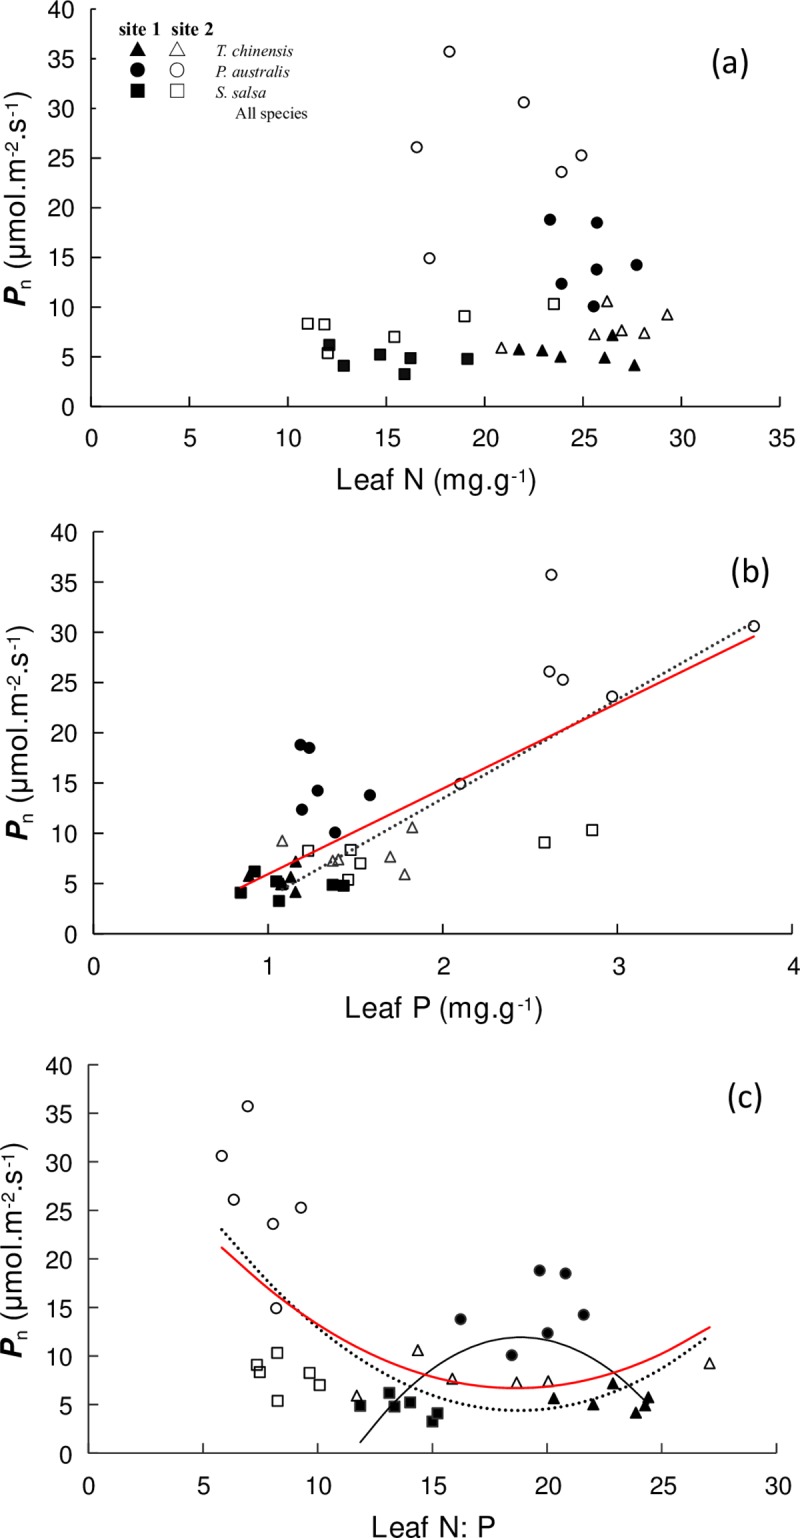
Relationships between leaf nutrient conditions and Pn of halophytic plant communities.(a) Leaf N and Pn (equations for sites 1 and 2 and all species: P > 0.05). (b) Leaf P and Pn (equation for site 1: P = 0.081; equation for site 2: y = 9.8482x − 6.2357, R2 = 0.589, P < 0.001; equation for all species: y = 8.5006x − 2.5626, R2 = 0.542, P < 0.001). (c) Leaf N:P and Pn (equation for site 1: y = −0.2213x2 + 8.3418x − 66.676, R2 = 0.377, P = 0.029; equation for site 2: y = 0.1112x2 − 4.1707x + 43.505, R2 = 0.372, P = 0.031; equation for all species: y = 0.0879x2 − 3.277x + 37.24, R2 = 0.306, P = 0.002).